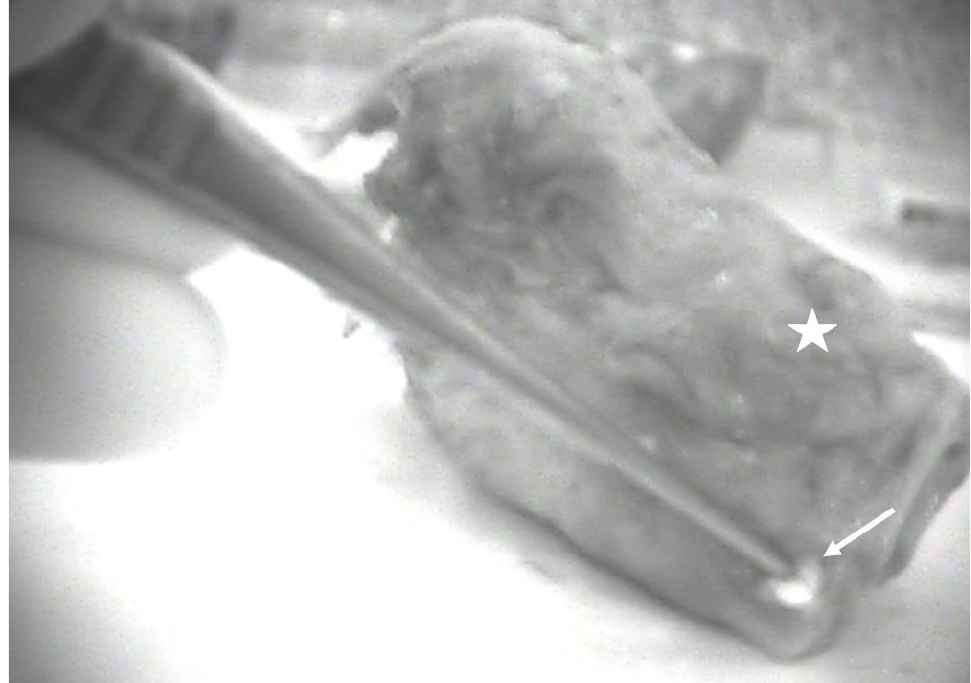
Figure 3. Lateral view of a total laryngectomy specimen (white star) seen with the near-infrared camera showing one autofluorescent parathyroid gland (white arrow).